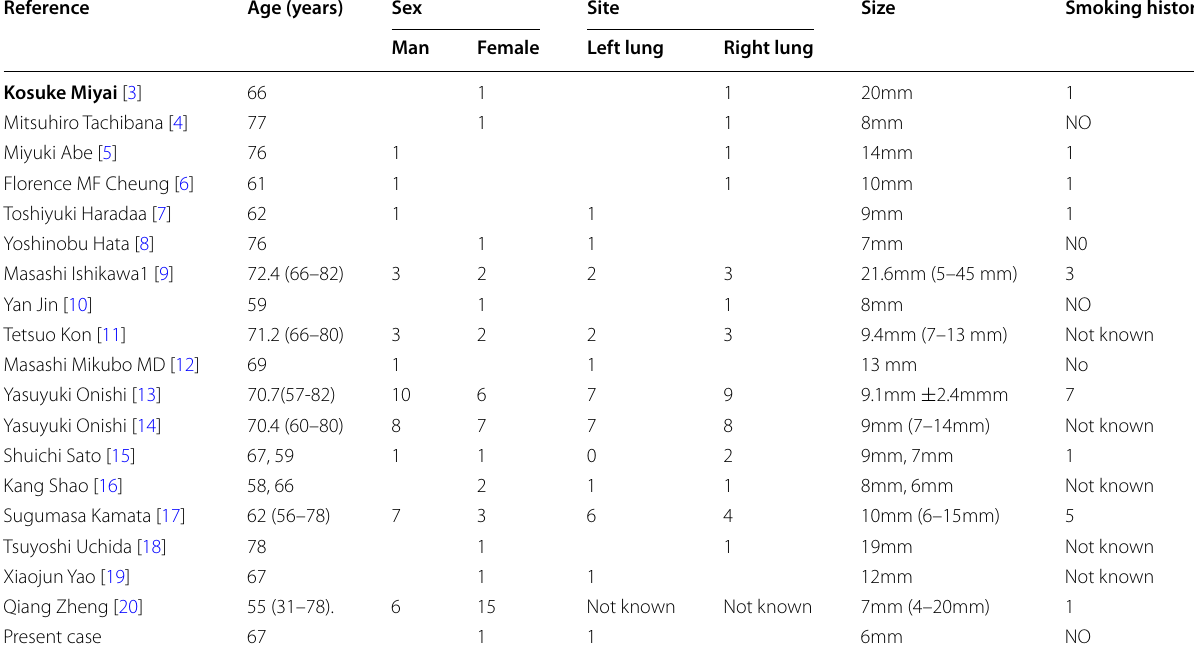
Table 3 Basic characteristics of reported cases